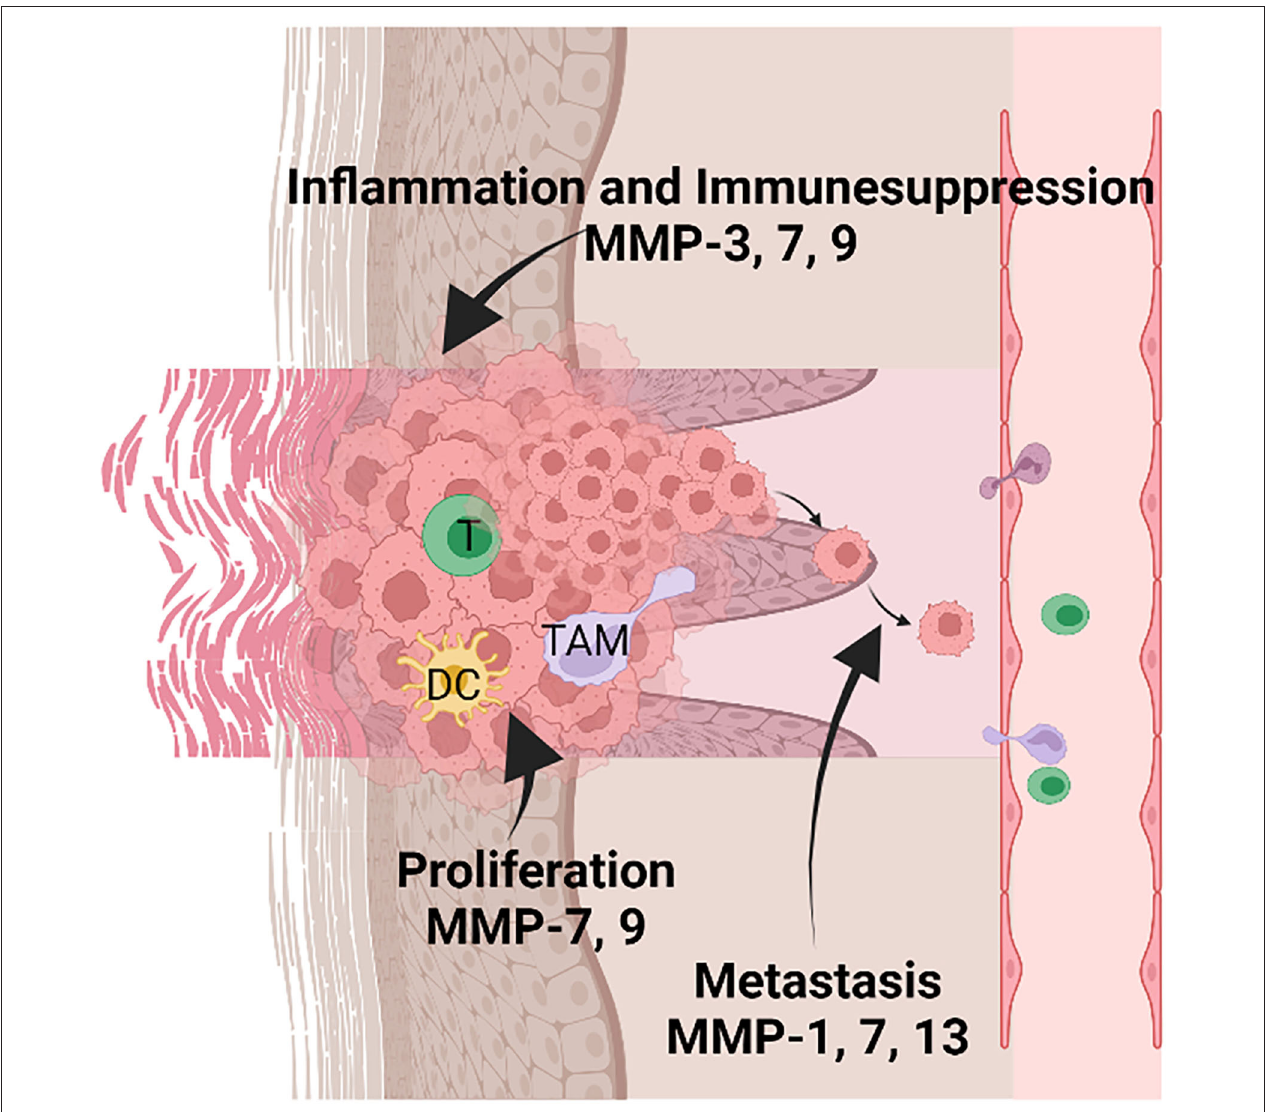
FIGURE 3 | MMPs’ involvement in inflammation, tumor proliferation, and metastasis in keratinocyte-derived tumors. Tumor-infiltrating immune cells are comprised of several populations such as T lymphocytes (T), dendritic cells (DC), and tumor-associated macrophages (TAM). MMP-3, 7, and 9 are mainly involved in sustaining